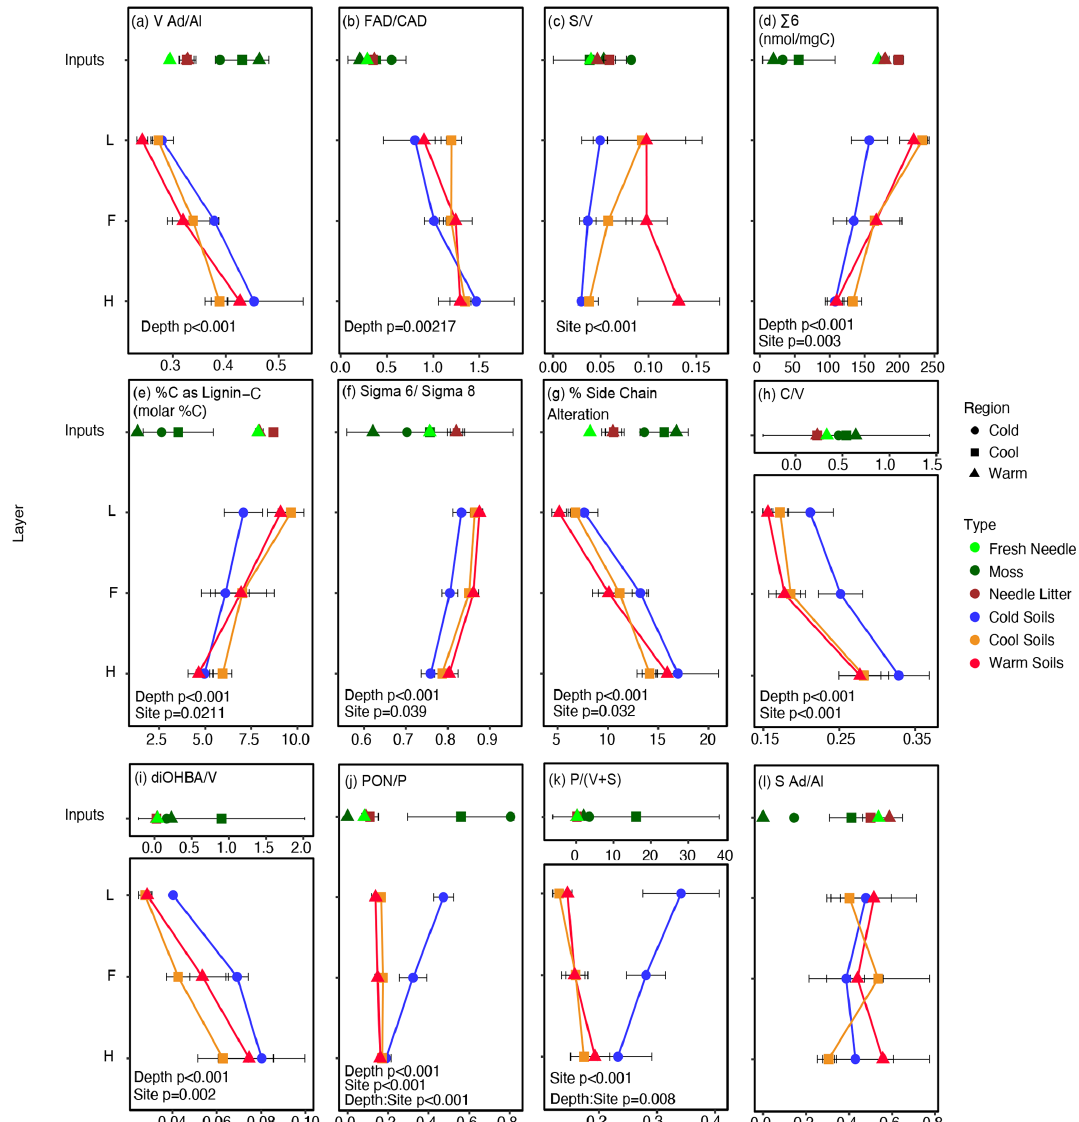
Figure 1. CuO-measured lignin phenol content in soils and input materials at one site per climate region. Moss samples in the Warm and Cold regions are composite samples based on dominant species cover, while in the Cool region individual moss species are plotted as the average and standard deviation with equal weights to show variability in moss signatures in phenolic signatures present in these forests. Green, brown, and fresh balsam fir needles from the Warm and Cool regions were also measured. The ratio of vanillic acid to vanillin ( V Ad / Al ) (a) and the ratio of ferulic acid to p-coumaric acid (FAD / CAD) (b) increase with depth, while the ratio of syringyl to vanillyl ( S /V ) (c) is different by site. The sum of syringyl and vanillyl phenols ( (cid:80) 6) (d) ; %C as lignin C (e) ; the ratio of (cid:80) 6 to the sum of all cinnamyl, syringyl, and vanillyl phenols ( (cid:80) 6: (cid:80) 8) (f) ; percent side chain alteration (g) ; the ratio of cinnamyl to vanillyl ( C /V ) (h) ; and the ratio of dihydroxybenzoic acid to vanillyl (diOHBA /V ) (i) all vary with depth and site. The ratio of p-hydroxyacetophenone to p-hydroxyl (PON /P ) (j) varied with depth and site and exhibited a depth x site interaction, while the ratio of p-hydroxyl to the sum of vanillyl and syringyl phenols ( P /(V + S) ) (k) varied with site and exhibited a depth x site interaction. The ratio of syringyl acids to aldehydes ( S Ad / Al ) (l) shows no trend with depth or the site. Soil horizons are indicated as the L, F, and H of the organic layer. The alpha level was set to 0.05; anything over this threshold was not reported on the figure. For clarity the labels and units (if applicable) for data presented are included in the figure plot subtitles rather than with each axis. Labels without units represent unitless ratios or